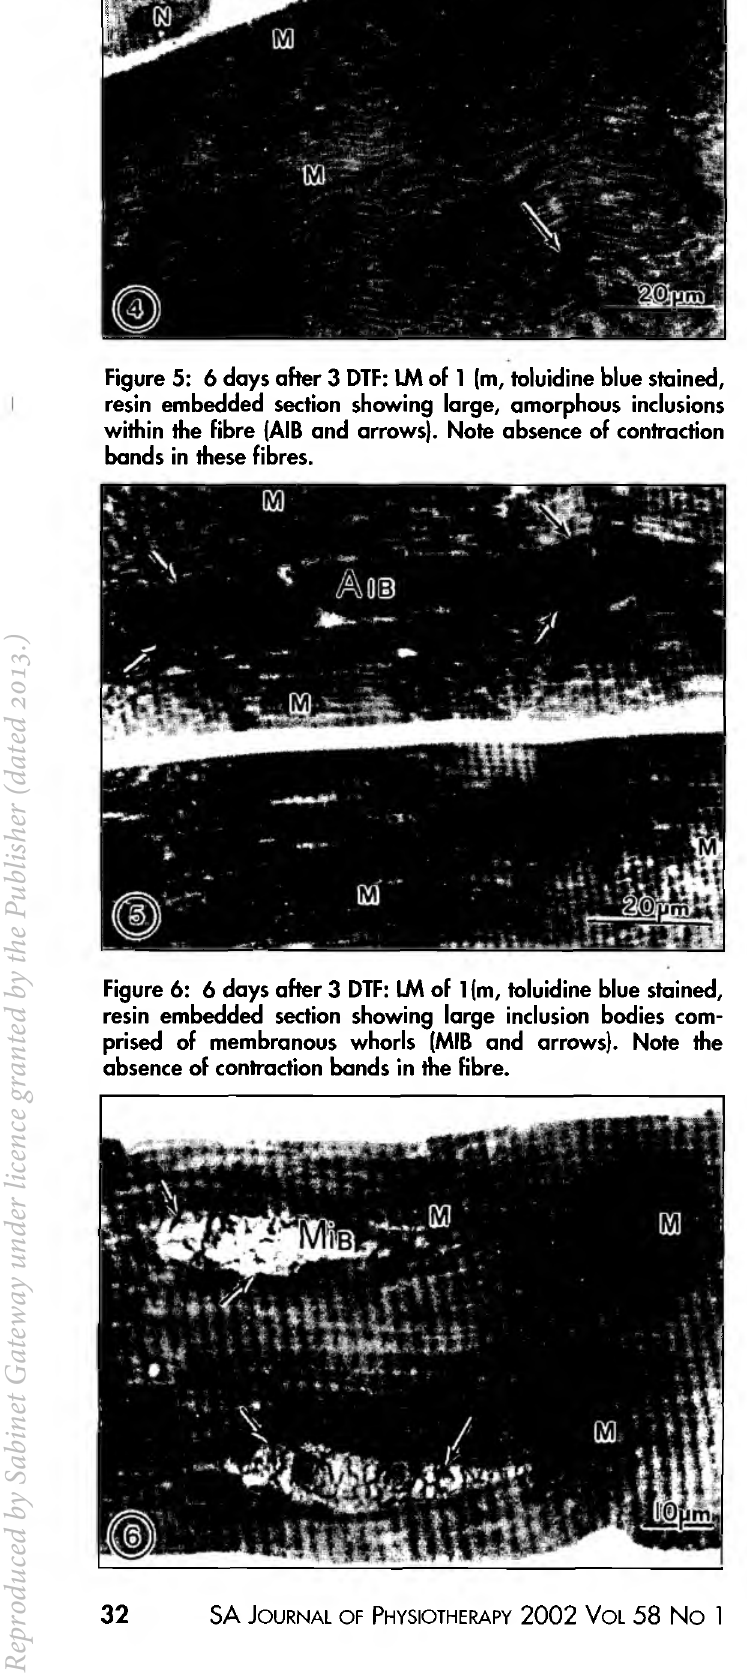
Figure 4: 48 hours after 1 DTF: LM of 1 (m, toluidine blue stained, resin embedded section showing occasional peripheral and internal contraction bands involving up to 4 sarcomeres (arrowed). N = nucleus.